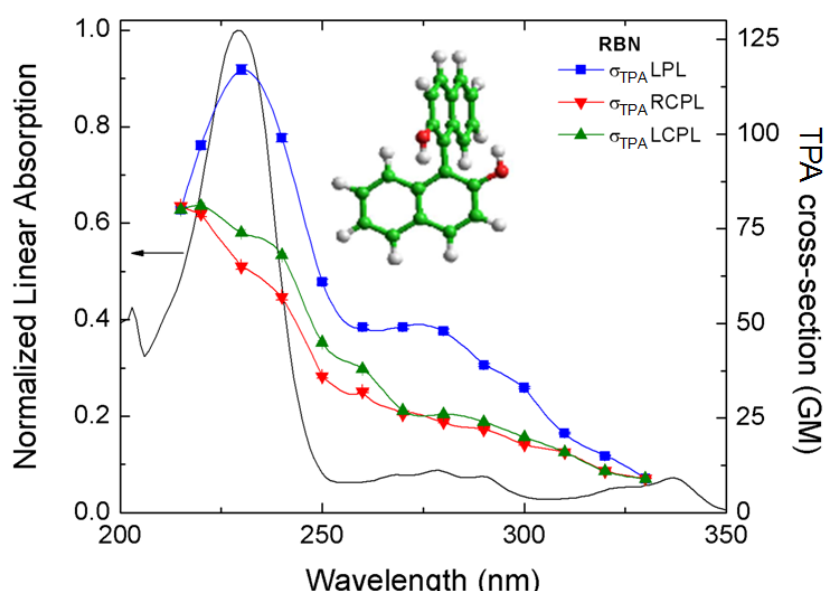
Figure 8. Double L-scan TPA spectra of R -BINOL/THF pumping with RCPL (red solid triangles), LCPL (green solid triangles) and LPL (blue solid squares) and display at half of the excitation wavelength. The normalized linear spectrum is also plotted for comparison (black solid line)